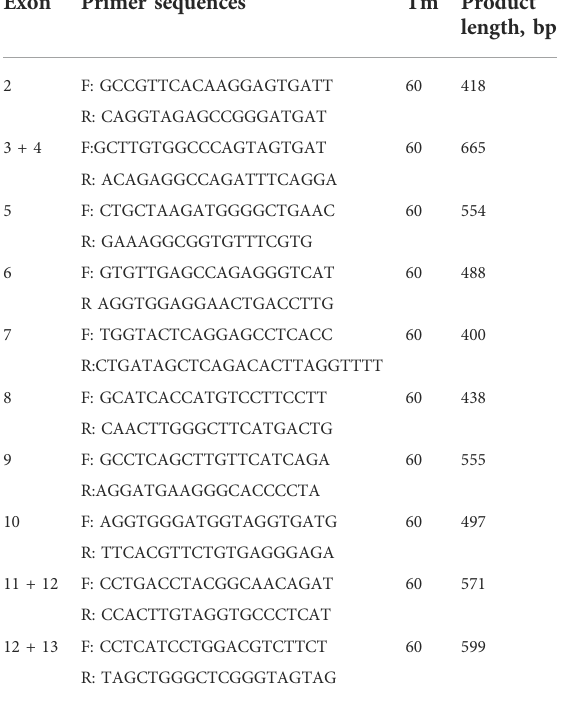
TABLE 1 The detailed information of